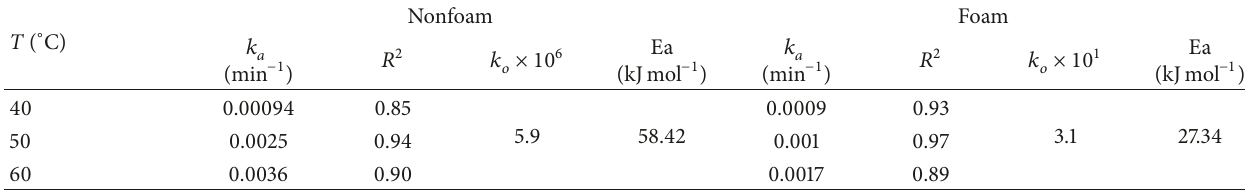
Table 5: The Arrhenius parameters for antioxidant activity degradation.